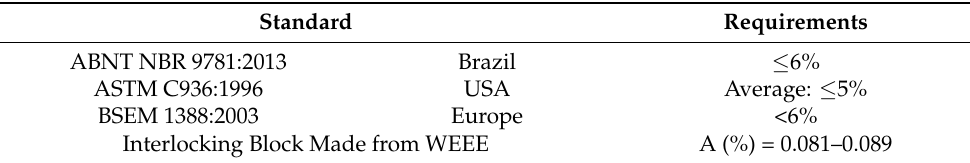
Table 4. Comparative table of absorption